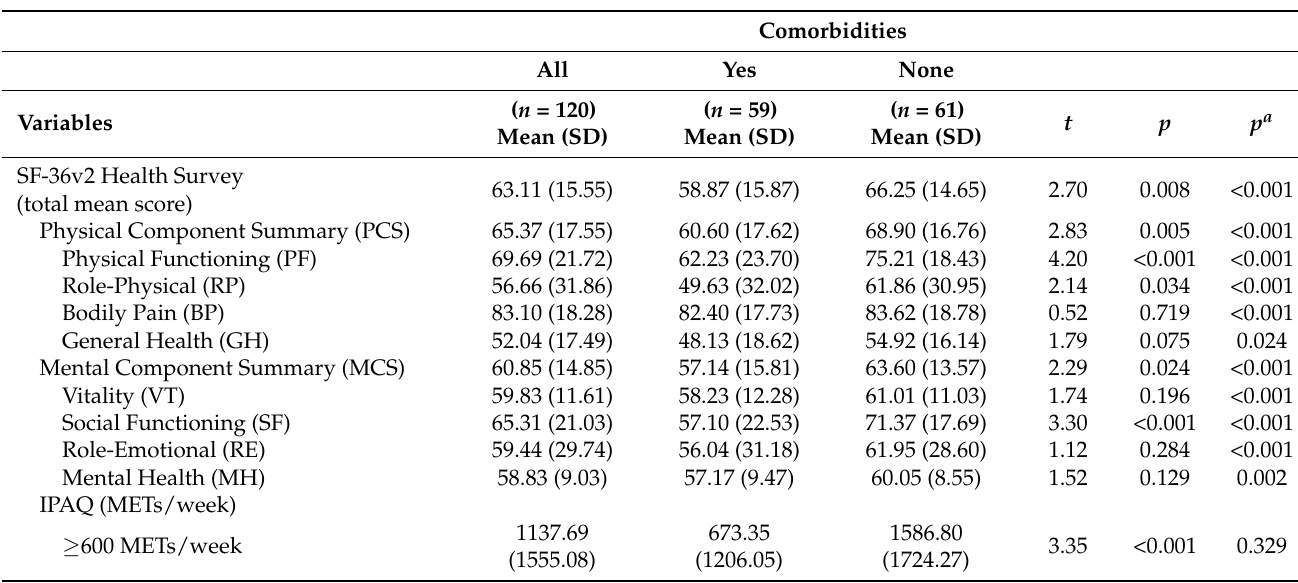
Table 3. Comparison of health-related quality of life and physical activity of patients with and without comorbidities ( n = 120). Comorbidities